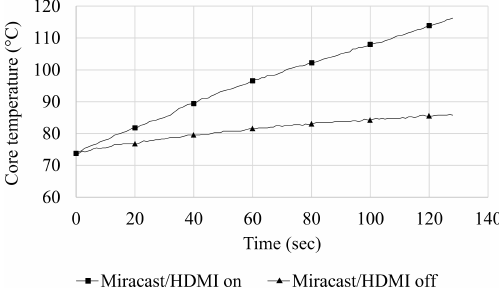
Figure 5. Comparison of CPU core’s temperature changes with and without using display interfaces.